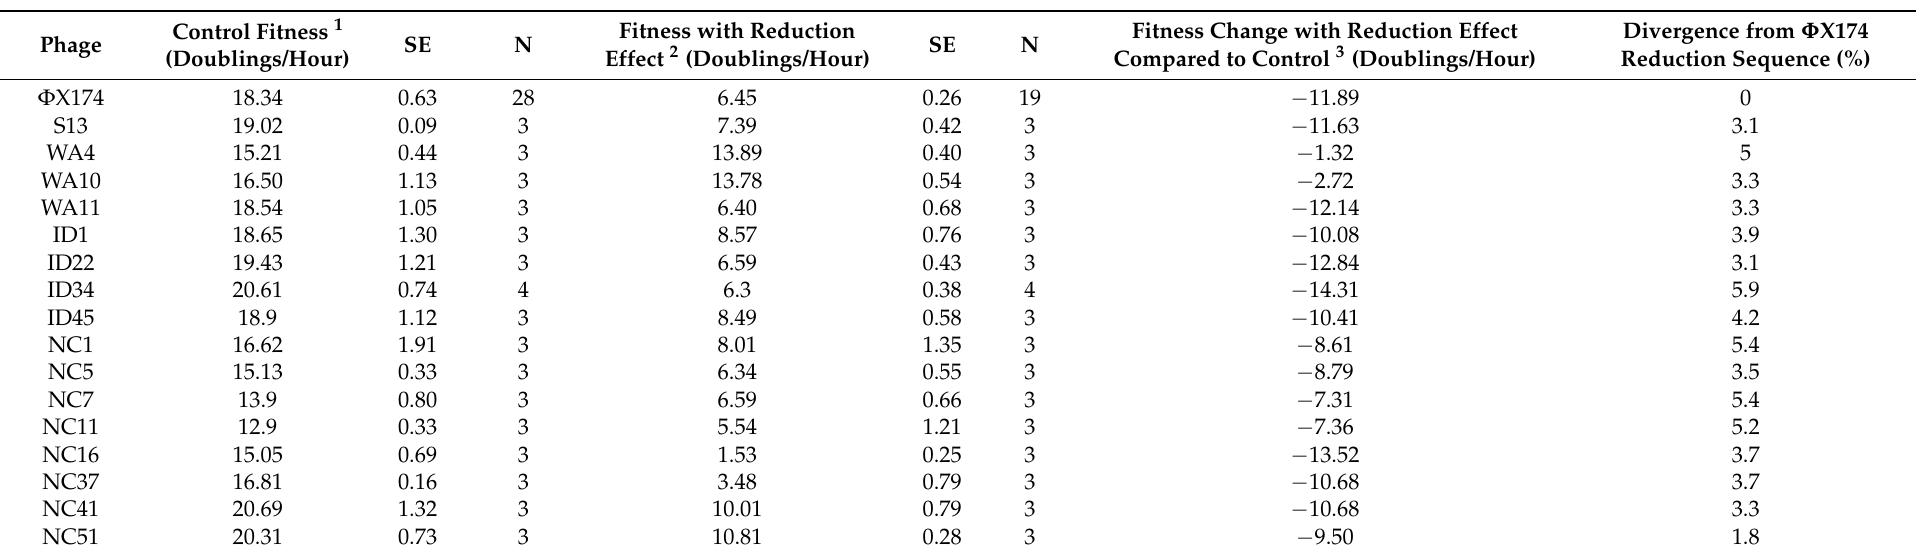
Table 1. Summary of fitness data for Φ X174-like